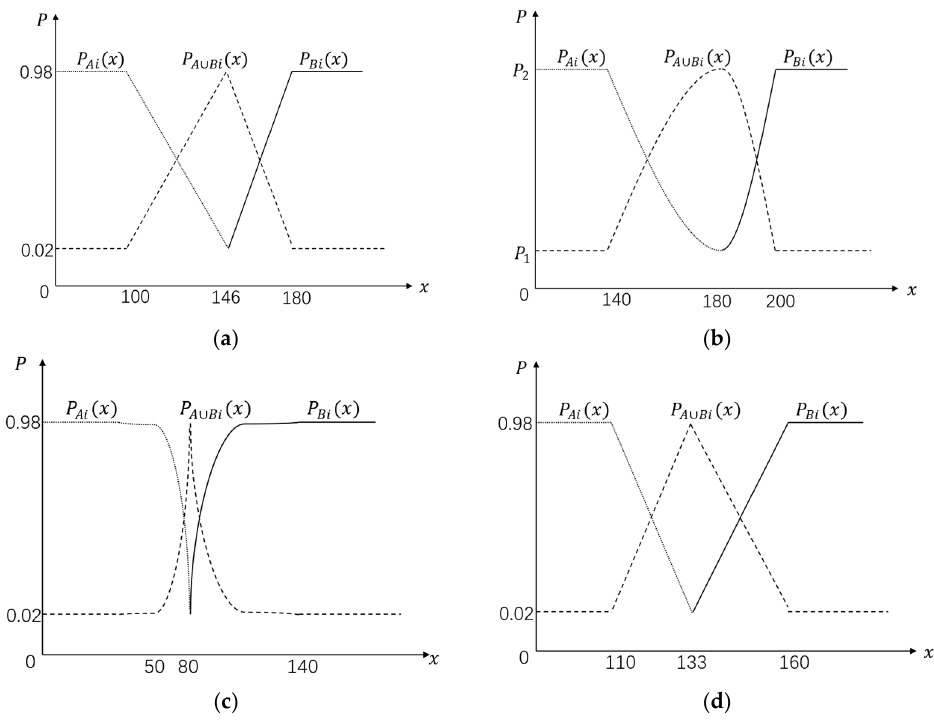
Figure 6. The BPA function of features: ( a ) HD; ( b ) IN; ( c ) FE; ( d ) NDVI.